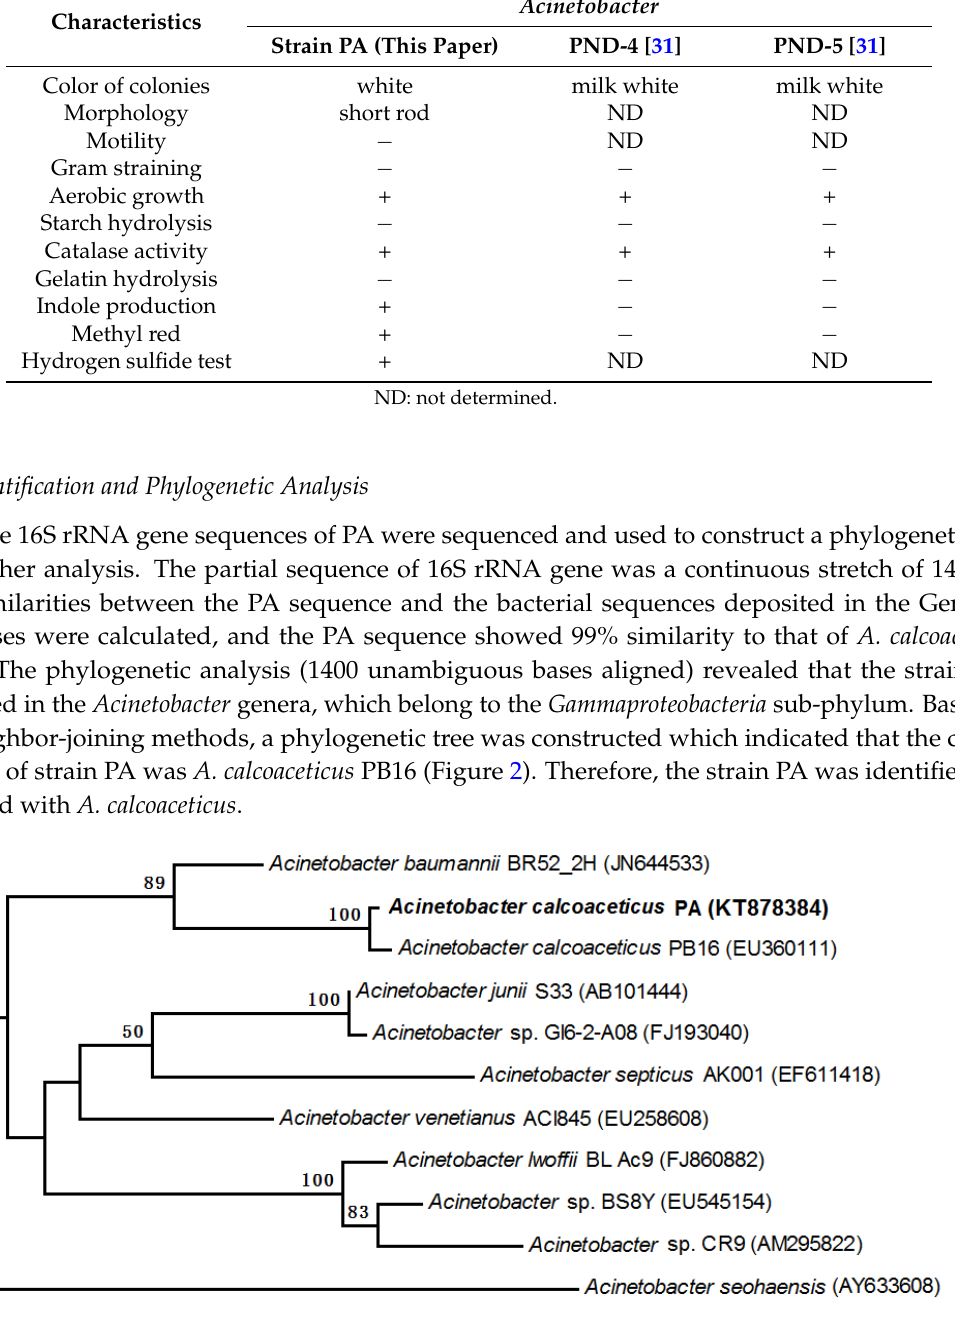
Figure 2. Phylogenetic relationship based on the 16S rRNA gene sequences of strain PA and related organisms from the GenBank database. Bootstrap values were calculated from 1000 replications of Kimura 2-parameter, and bootstrap values higher than 50% were shown. The scale bar represents 0.002 changes per sequence position.